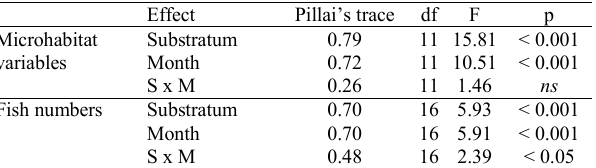
Table 3. Results of factorial MANOVAs testing the effects of substratum type (consolidated and unconsolidated), sampling month (May and October) and their interaction term on microhabitat variables (rugosity, number of crevices, substratum height and benthic cover) and fish abundances (rare species excluded). ns :